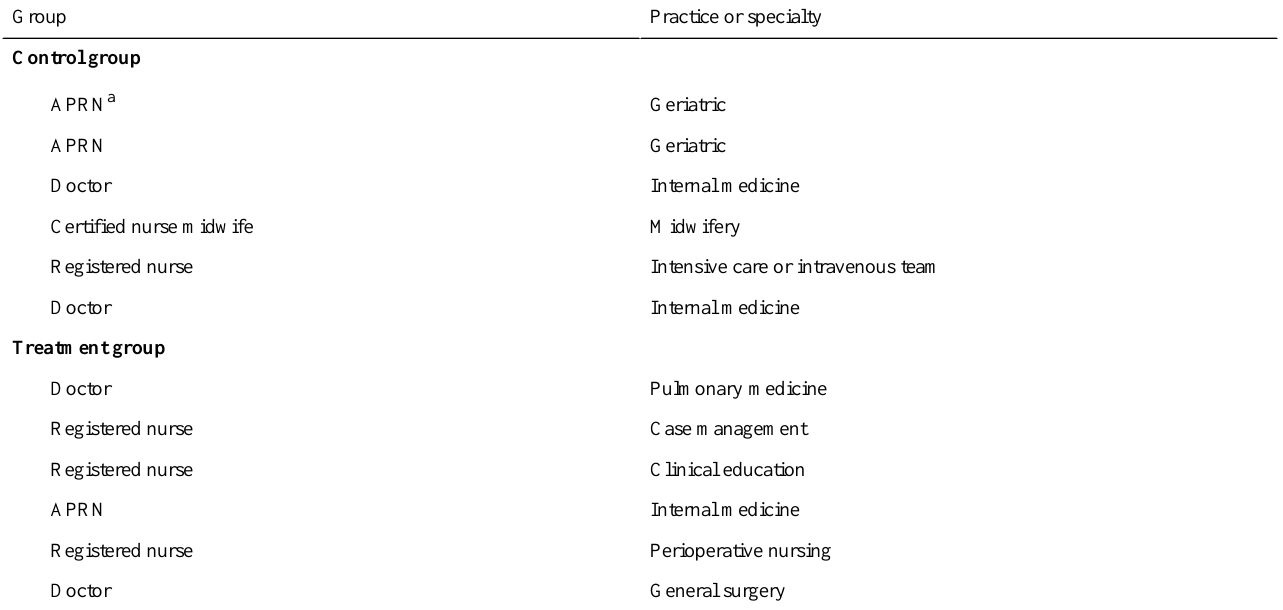
Table 5. Background of participants (12 participants).